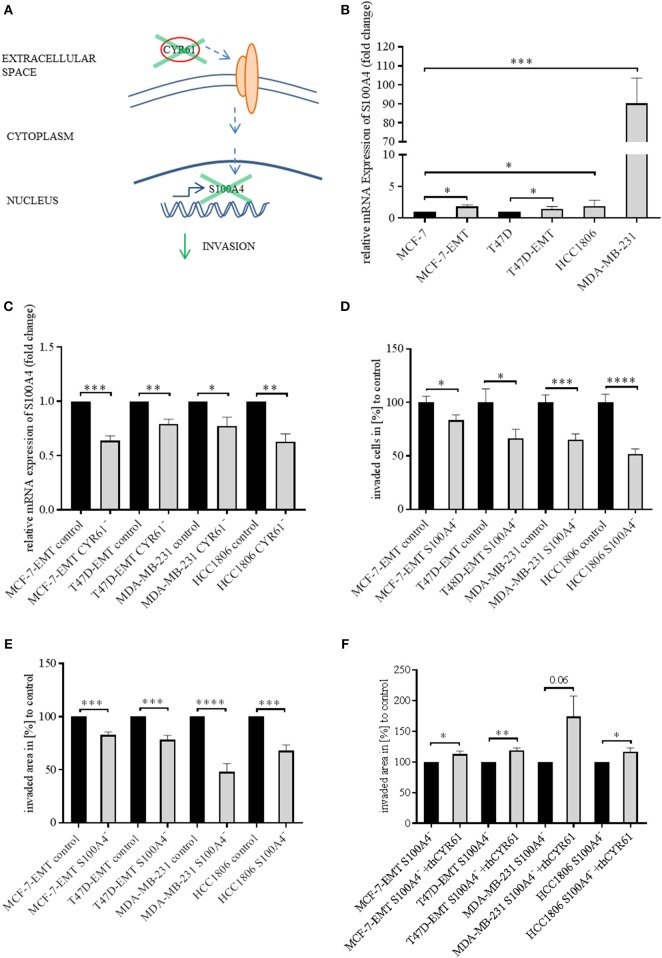
Suppression of CYR61 reduces S100A4 expression. (A) Scheme illustrating hypothesis of CYR61-dependent cell invasion regulation. (B) Relative S100A4 expression of invasive breast cancer cell lines compared to non-invasive controls. Data represent mean ± SEM. Using unpaired, two-tailed t-test analysis. MCF-7-EMT n = 5; T47D-EMT n = 5; MDA-MB-231 n = 4; HCC1806 n = 6; *P < 0.05;
***P < 0.005 (C) Relative S100A4 expression of invasive breast cancer cell lines 96 h after transient CYR61 transfection compared to non-invasive controls. Data represent mean ± SEM. Using unpaired, two-tailed t-test analysis. MCF-7-EMT n = 4; T47D-EMT n = 3; MDA-MB-231 n = 4; HCC1806 n = 3; *P < 0.05; **P < 0.01; ***P < 0.005 (D) 2D Invasion analysis of co-cultured (MG-63, osteosarcoma cells) breast cancer cells transient transfected with S100A4 siRNA for 96 h. Percentage of cell invasion compared to controls was assessed by counting invaded cells under the filter in 4 random filter regions. Data represent mean ± SEM. MCF-7-EMT n = 36; T47D-EMT n = 36; MDA-MB-231 n = 24; HCC1806 n = 36; *
P < 0.05; ***P < 0.005; ****
P < 0.0001 (E) 3D invasion analysis of breast cancer spheroids seeded after transient siRNA transfection. Spheroid area was assessed 48 h after adding Matrigel using polygonal selection and compared to spheroid area at time point 0 (adding of Matrigel). Area growth was compared to area growth of control spheroids. Data represent mean ± SEM. Using unpaired, two-tailed t-test analysis. MCF-7-EMT n = 6; T47D-EMT n = 6; MDA-MB-231 n = 12; HCC1806 n = 6; ***P < 0.005;
****P < 0.0001 (F) 3D invasion analysis of breast cancer spheroids seeded after transient S100A4 siRNA transfection and treated with rhCYR61. Spheroid area was assessed 48 h after adding Matrigel and rhCYR61 using polygonal selection and compared to spheroid area at time point 0 (adding of Matrigel + rhCYR61). Area growth was compared to area growth of S100A4- spheroids. Data represent mean ± SEM. Using unpaired, two-tailed t-test analysis. MCF-7-EMT n = 4; T47D-EMT n = 4; MDA-MB-231 n = 5; HCC1806 n = 6; *P < 0.05;
**P < 0.001.